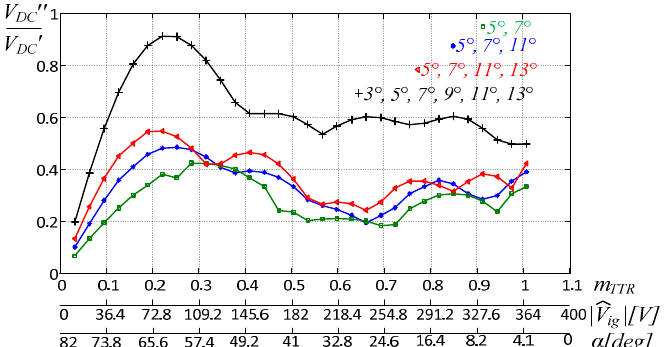
Figure 9. Minimum V DC ''/ V DC ' requirement vs. peak amplitude of PMSG phase voltage, m TTR , and α .